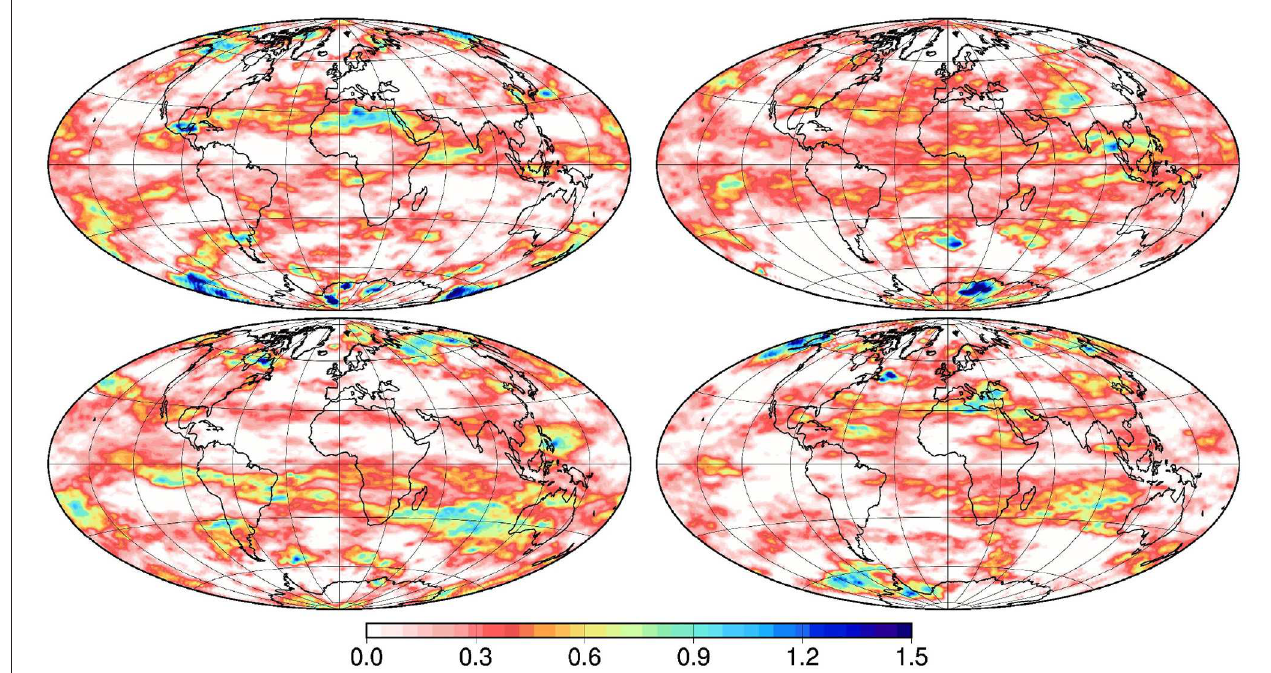
FIGURE 7 | Sample of 4 vectors from the augmented